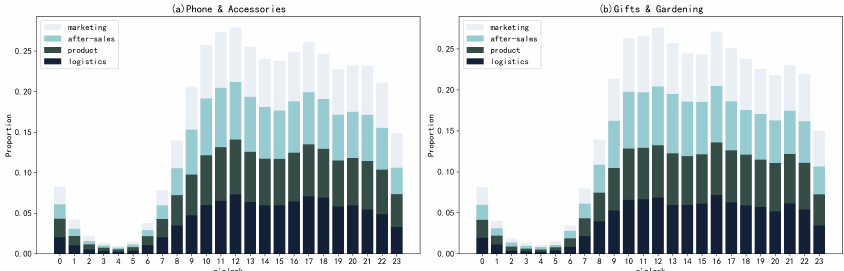
Figure A5. Proportions of main reasons for negative reviews on an hourly scale for the other two sectors. ( a ) is a stacked histogram for sector Phone and Accessories and ( b ) is for Gifts and Flowers. The x -axis is hours in a day, from 0 to 23, and the y -axis represents the proportion at the corresponding hour. Compared with the two sectors in Figure A4, it can be concluded that Phone and Accessories are products with strong personal features such as Clothing, while peaks in the sector Gifts and Flowers often appear at 10–12, 16 and 21–22 o’clock, which is often delivery